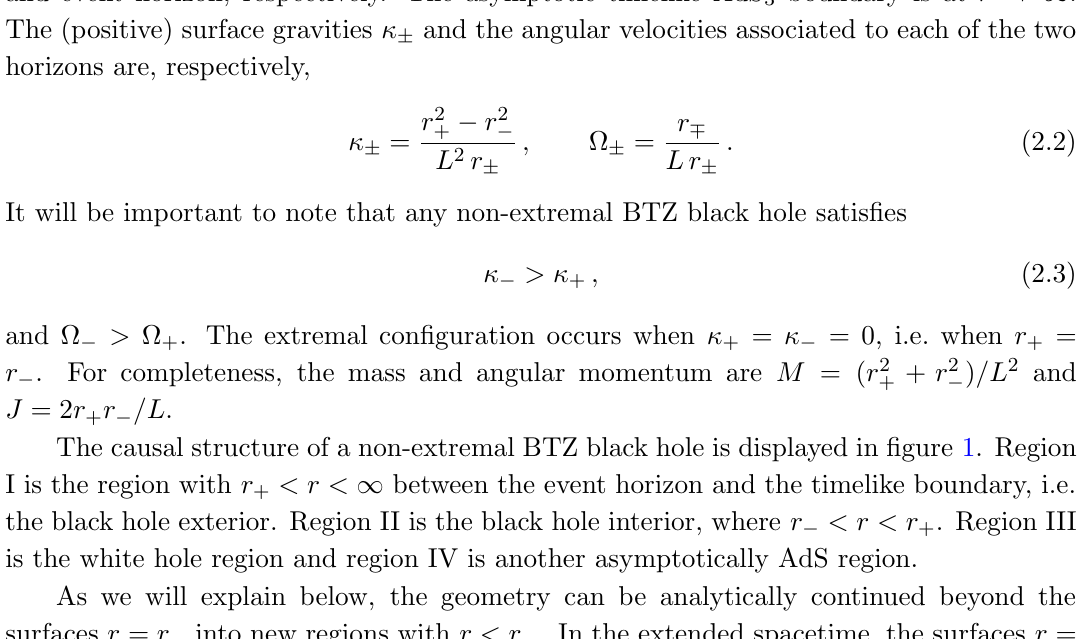
R . CH + are the L;R L